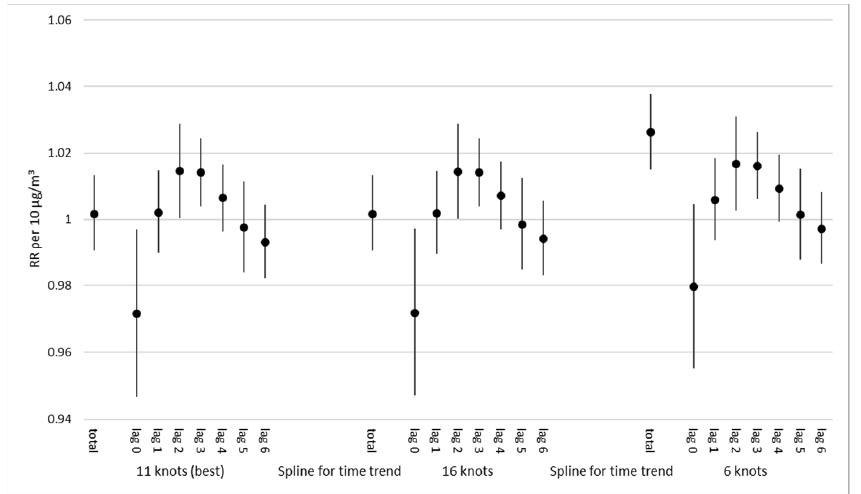
Figure A2. Sensitivity analysis: Effect (relative risk and 95% confidence interval) on stationary hospital admissions per 10 μ g/m³ increase in PM2.5, total effect and daily effects over 7 consecutive days (lag 0–6): Optimal model (11 knots for the time smoother) compared to 16 and 6 knots for the 3 ‐ year period.